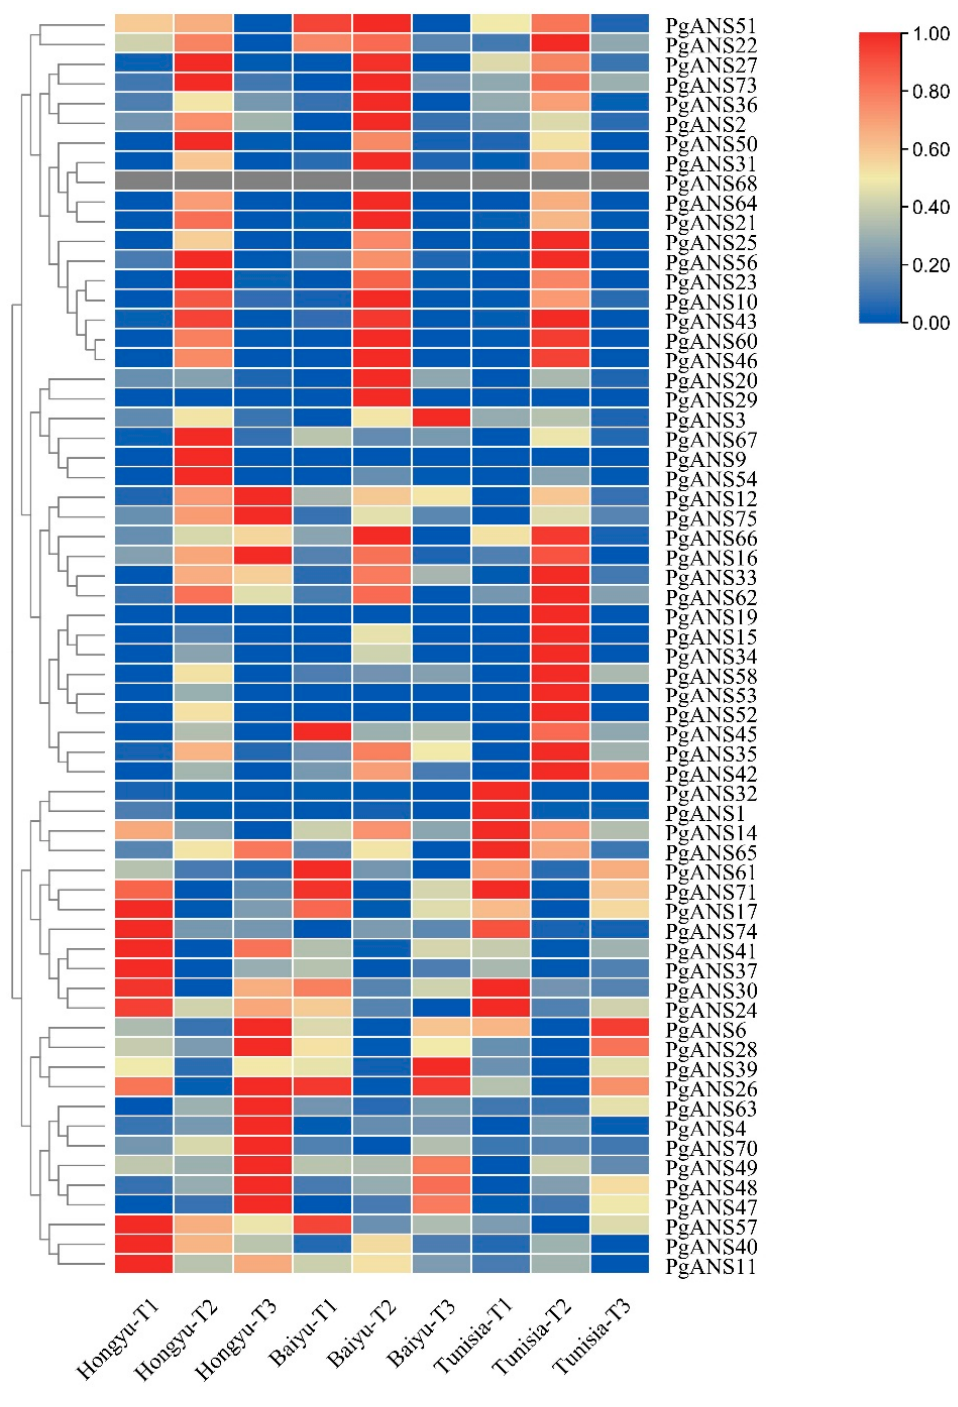
Figure 4. Heat map of the expression of pomegranate ANS genes in 3 species at different growth periods. T1—40 days after blooming period, T2—80 days after blooming period, T3—120 days after blooming period, ‘Hongyu’—Hongyushizishizi, ‘Baiyu’—Baiyushizi.